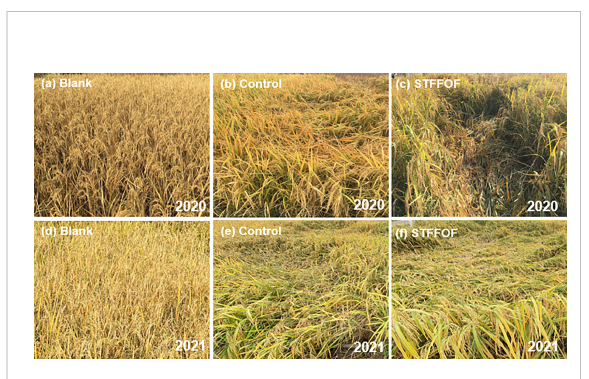
FIGURE 2 Effect of soil-testing formula fertilization using organic fertilizer (STFFOF) for 11 years on lodging incidence of rice. The representative pictures are shown for blank [no fertilizer application (A, D) ], control (B, E) , and STFFOF [treatment (C, F) ] plots during grain fi lling stage of rice. (A – C) Photographs taken on